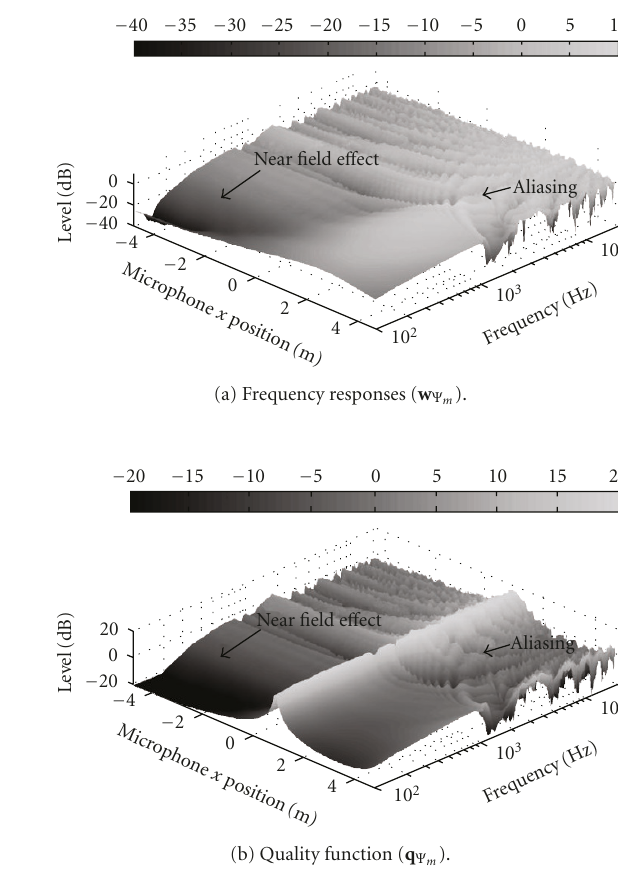
Figure 4: Frequency responses ( w Ψ of an 8 m, 48-channel, loudspeaker array simulated on a line at 2m from the loudspeaker array for synthesis of a source of degree − 2 (far source of Figure 3).